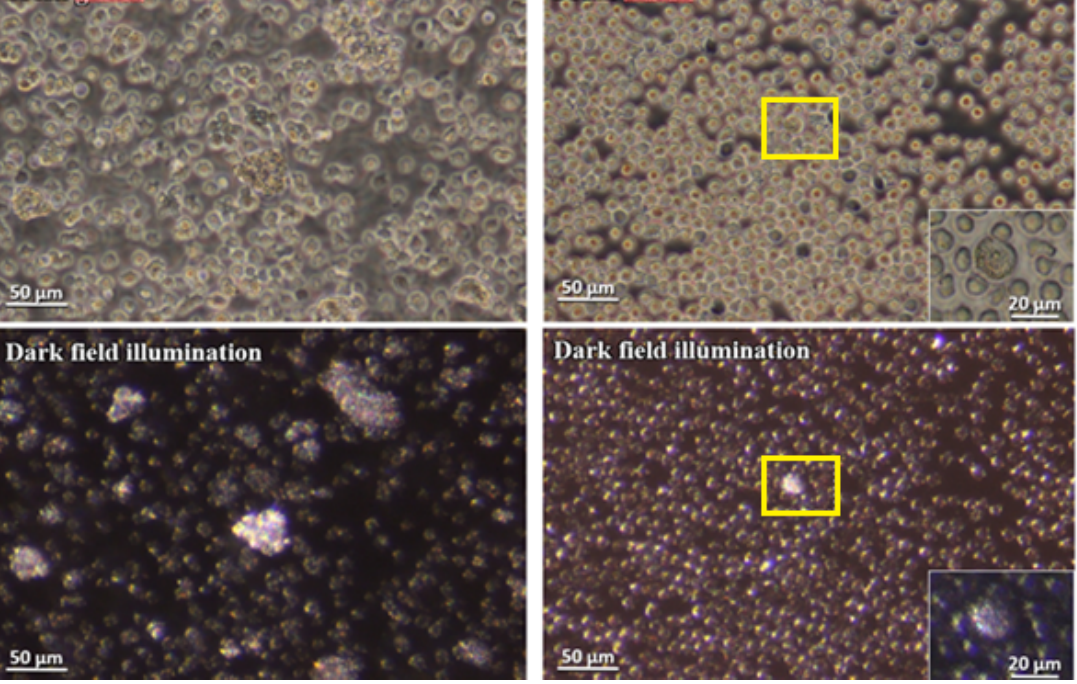
Figure 1. Fresh gonadal primordial germ cells (gPGCs) and circulating blood primordial germ cells (cPGCs) observed under an inverted phase-contrast microscope; gPGCs and cPGCs are visualized in darkfield illumination. The PGCs are distinguished as bright, illuminated cells among other cell types (P.434242 patent application number). Magnification with 40× objective (Leica DMI8, Germany).